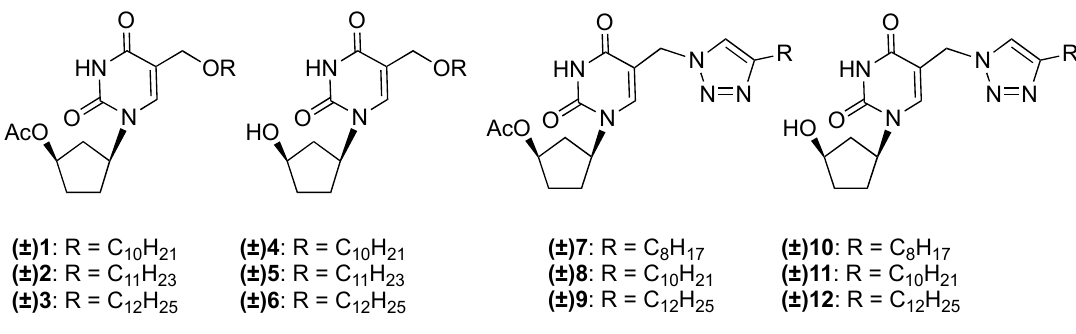
Figure 3. Target compounds.